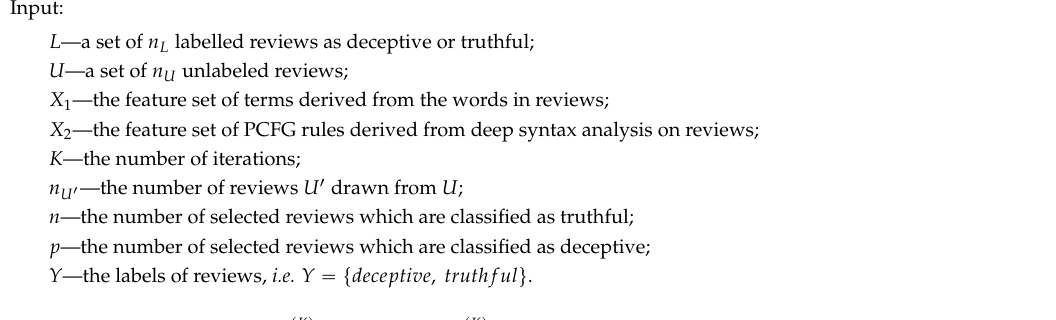
Algorithm 1. The CoSpa algorithm without details on selecting classified unlabeled reviews in the co-training